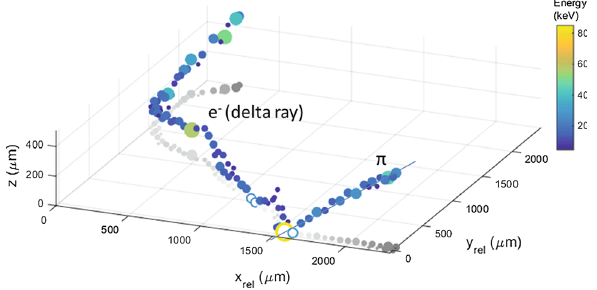
Fig. 12 Same as Fig. 9, but for a track from the measurement with 230V bias